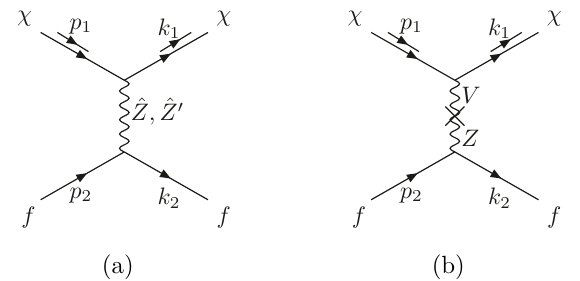
Figure 2. Plots (a) and (b) represent two different points of view of the DM- f (SM fermion) scattering through the vector-portal. In Plot (a), the mediators ˆ Z and ˆ Z 0 are mass eigenstats, and their amplitudes cancel each others miraculously. In Plot (b), there is only one diagram whose mediator involves a mixing between the V and Z µ µ